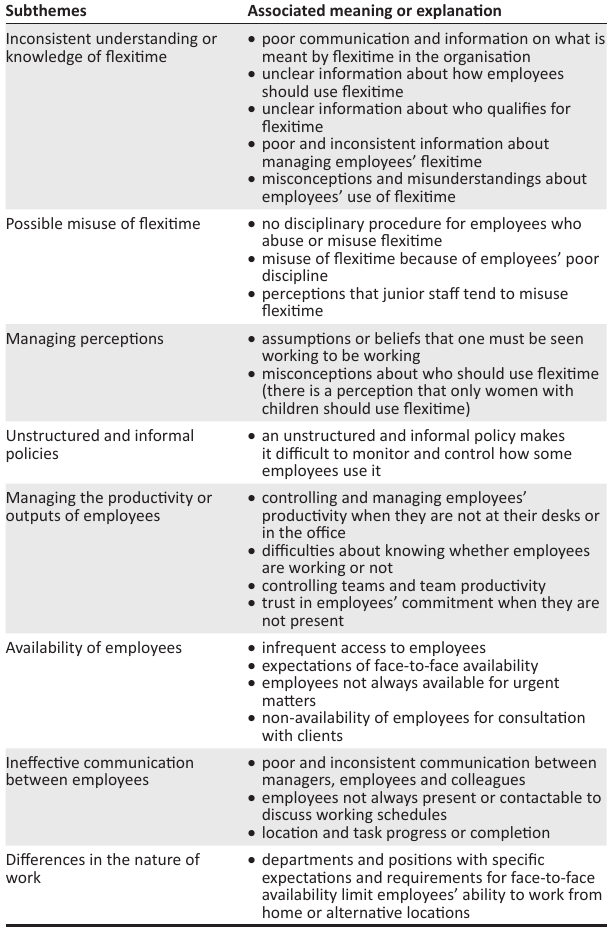
TABLE 2: General challenges associated with using